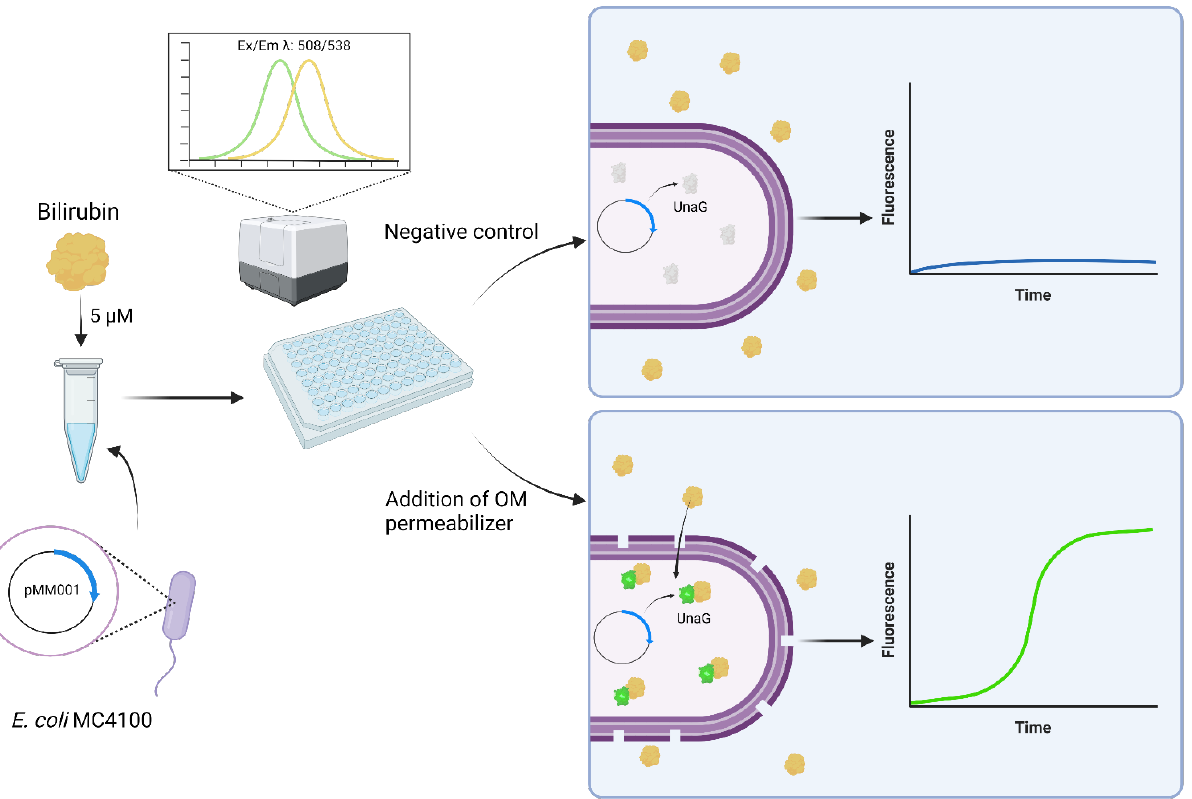
Figure 8. Schematic of the use of the reporter protein UnaG as an OM permeabilization whole-cell biosensor. Created with BioRender.com (accessed on 6 December 2022).